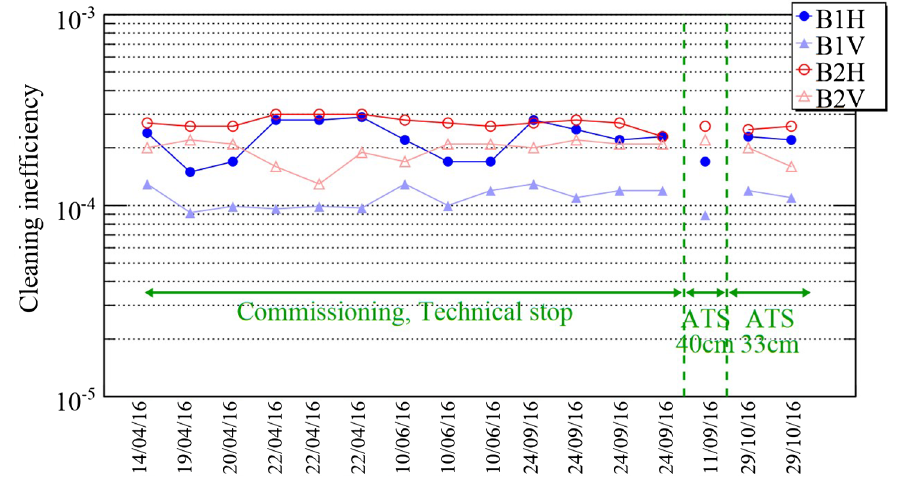
FIG. 4. Collimation inefficiency measured over the 2016 LHC run (non-ATS optics), and during the 2016 ATS machine development sessions. Courtesy of D. Mirarchi